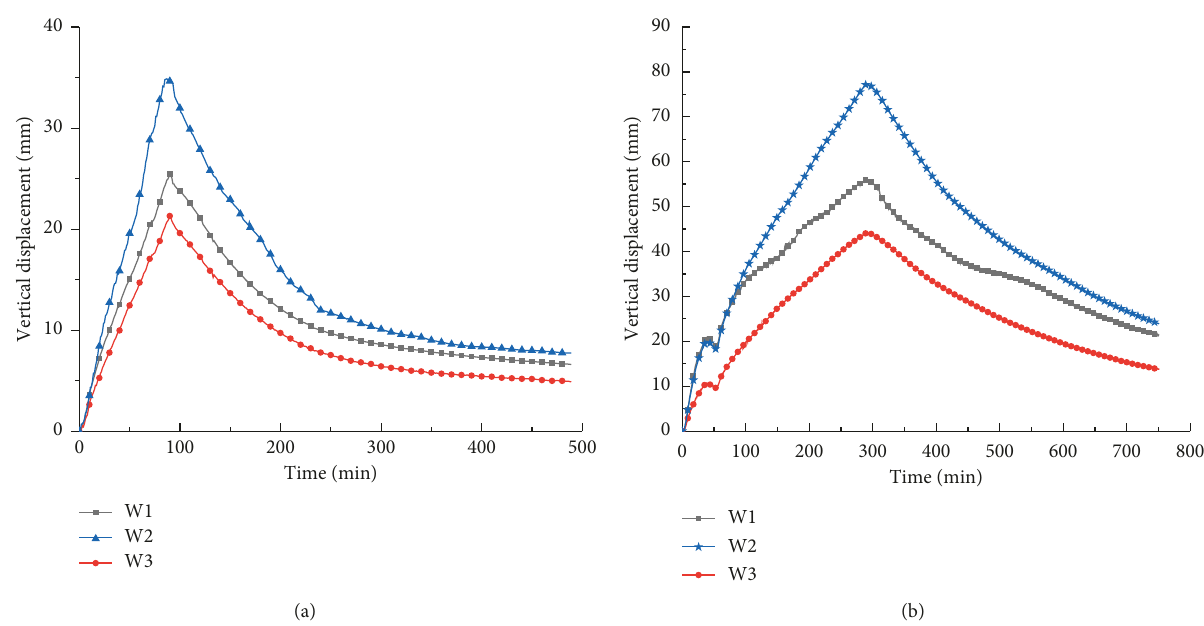
Figure 11: Vertical deflections-time relationship. (a) The first fire test slab. (b) The second fire test